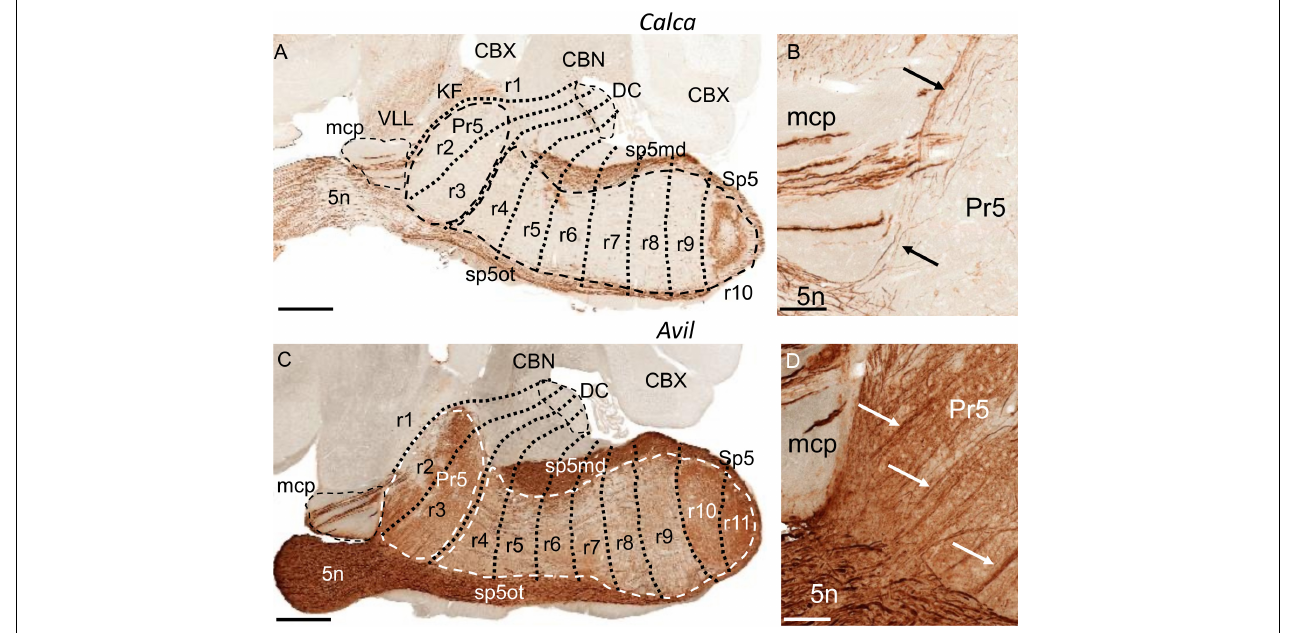
FIGURE 2 | Labeling of trigeminal primary afferent fibers in adult transgenic mice from the GENSAT database, processed for immunohistochemical detection of EGFP. (A,C) Respective parasagittal sections of adult brains from Calca and Avil mouse lines. The principal sensory (Pr5) and the spinal trigeminal nucleus (Sp5), the dorsal cochlear nuclei (DC) and the medial cerebellar peduncle (mcp) are, respectively, encircled by dashed lines. In addition to the trigeminal system, there is expression in the ventral nucleus of the lateral lemniscus (VLL) and in the Kölliker-Fuse nucleus (KF) in the section from the Calca line. (B,D) Respective details of the former sections, showing labeling in the trigeminal nerve root (5n), some labeled fibers within mcp, and labeled ascending trigeminal fibers (black and white arrows) within Pr5. CBN, cerebellar nuclei; CBX, cerebellar cortex; r, rhombomere(s); sp5md, mandibular fibers of the trigeminal tract; sp5ot, ophthalmic fibers of the trigeminal tract. (A,C) Scale bars = 500 µ m, (B,D) scale bars = 100 µ